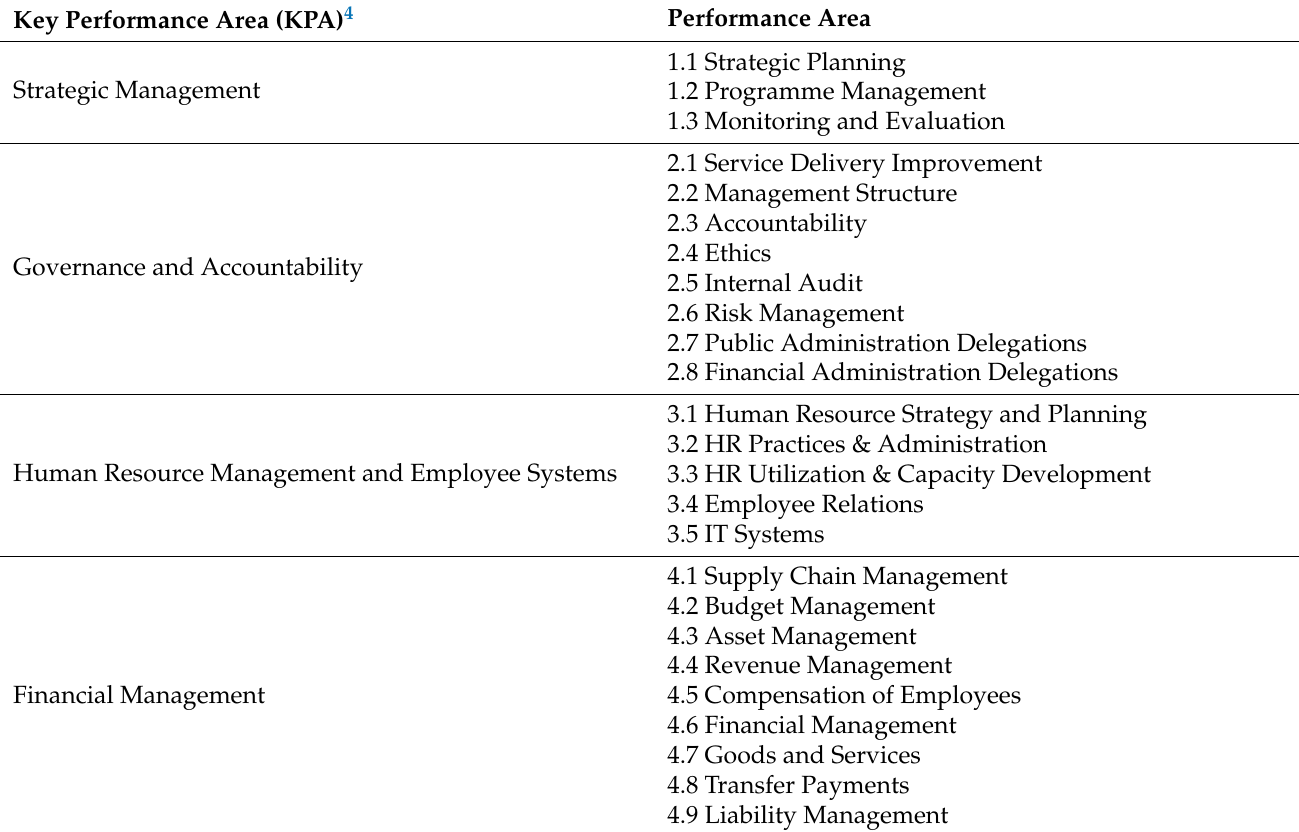
Table 3. The key performance areas and performance areas of the Management Performance Assess- ment Tool (MPAT) implementation guide (Source: Own construction from Management Performance Assessment Tool (MPAT)